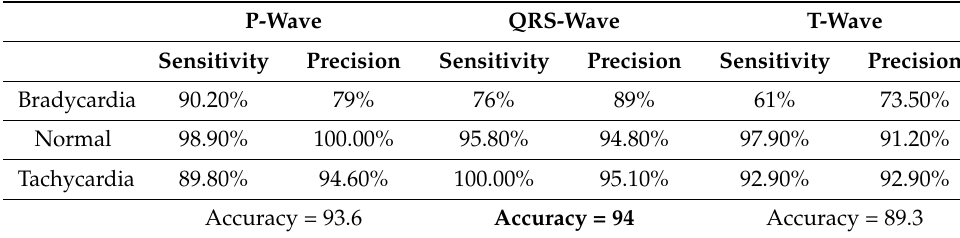
Table 3. Results of Irisgram and ShuffleNet.